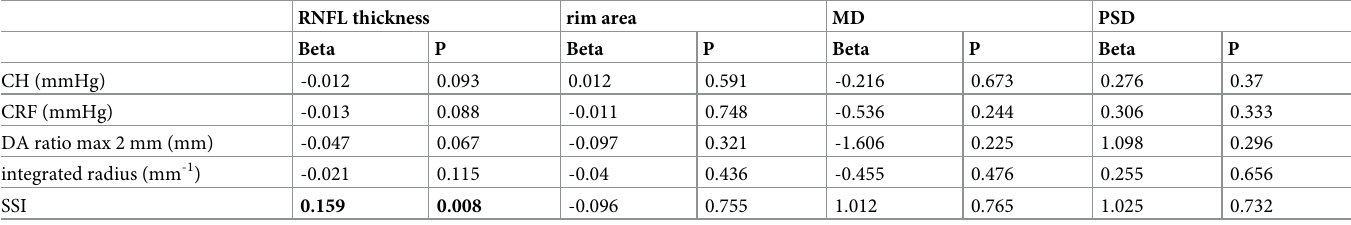
Table 3. Regression analysis of the association between corneal biomechanical parameters and functional (visual field) and structural (HRT) indices of glaucoma severity in high pressure glaucoma (HPG) patients using generalized estimating equations.